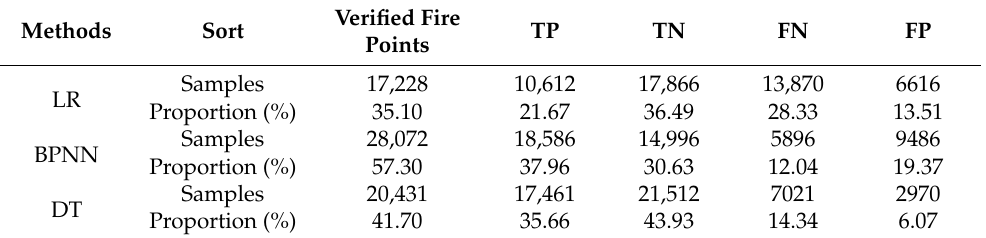
Table 2. Results for verification of fire points over Northeastern China in 2021 by the LR, BPNN, and DT method.